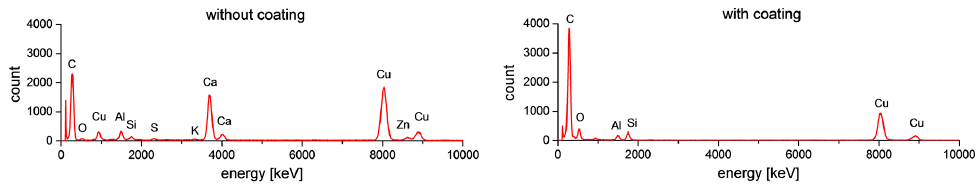
Figure 7. EDS results for carbon fibers without coating and with coating 2.